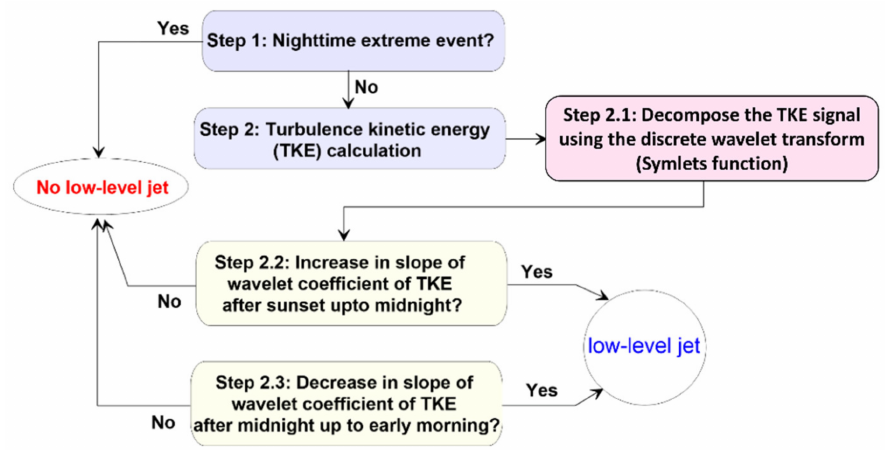
Figure 5. Flow chart for the low-level jet identification method using Symlets wavelet function and the slope of wavelet coefficients (SWT).